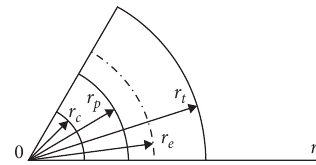
Figure 1: Finite cylindrical cavity expansion